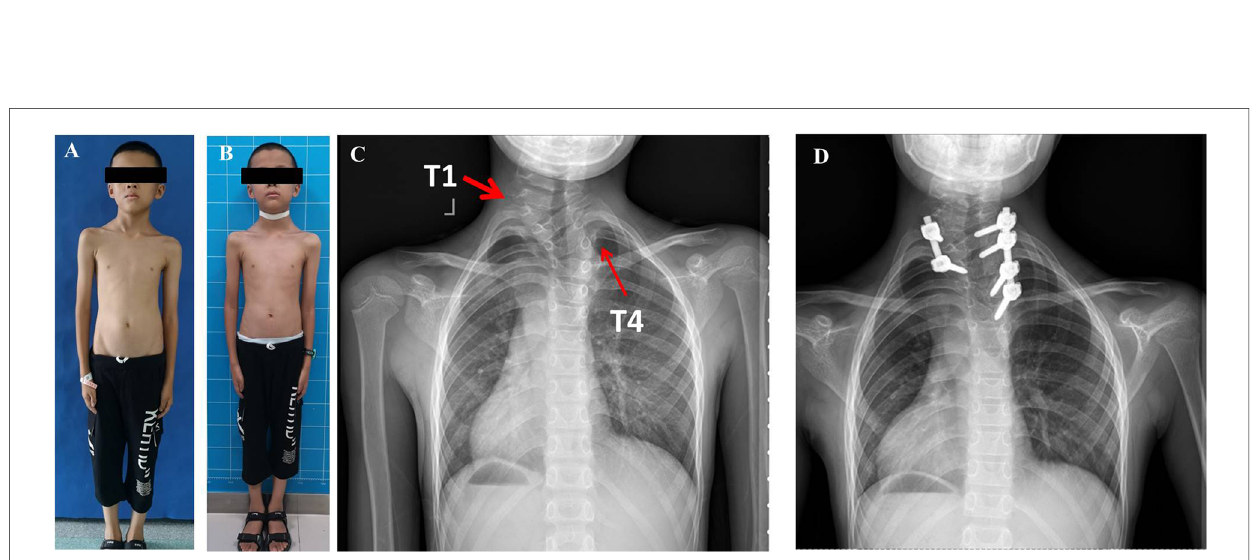
FIGURE 3 A 10 years old boy complained of neck pain and shoulder imbalance and was revealed to have two HVs at T1 and T4 ( A,C ). For the distal segment scoliosis, the T4 HV was removed and T2 to T6 vertebrae were instrumented on the convex side. For the proximal segment scoliosis, due to the dif fi culty of screw placement free hand in C7, a wedge osteotomy was performed between the lower part of the T1 hemivertebra and the upper part of the T2 vertebra, then the de fi cits were closed using screws at T1 and T3 vertebra. He achieved good shoulder balance and no neck pain 3 months postoperatively ( B,D ) Ji lilili